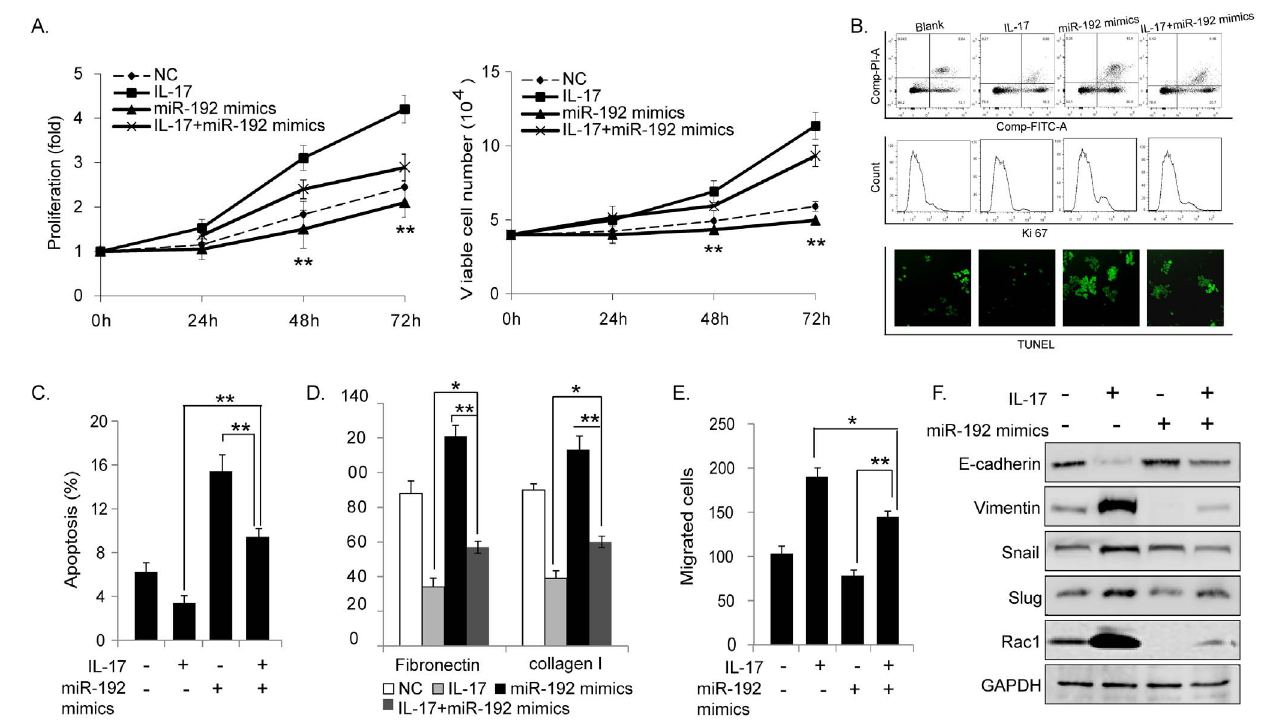
Fig. 4. Oncogenic effects of IL-17 on MM cells were mediated by repression of miR-192. Functional effects of IL-17 on MM1S cells with ectopic expression of miR-192 were evaluated. Overexpression of miR-192 significantly inhibited cell proliferation (A), induced cell apoptosis (B and C) and adhesion (D), suppressed cell migration (E) and EMT (F). IL-17 stimulation alleviated the above inhibitory effects of miR-192 compared with treatment with miR-192 mimics transfection alone. (**P , 0.01, *P , 0.05, Figure is representative of 3 experiments with similar